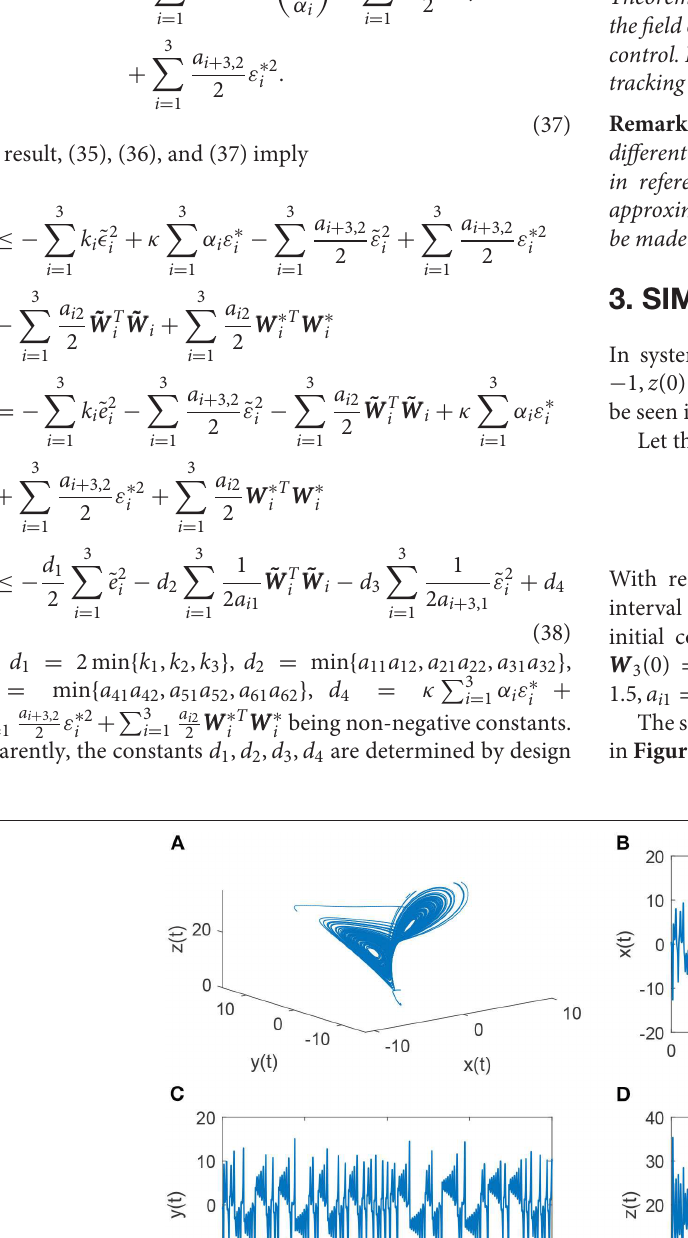
Frontiers in Physics |